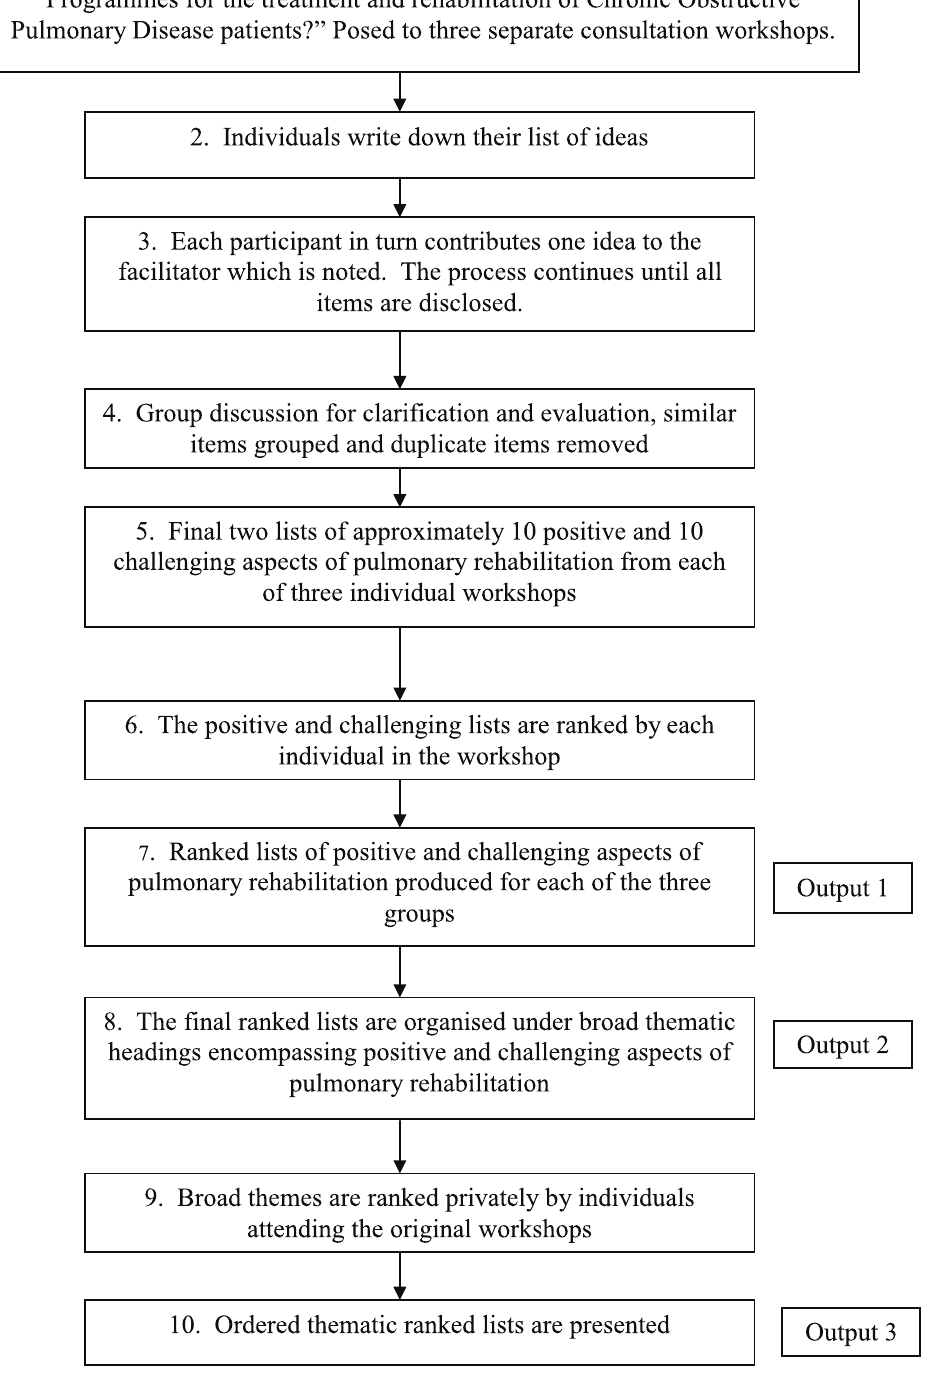
Figure 1. Flow diagram steps involved in the Nominal Group Technique process of the